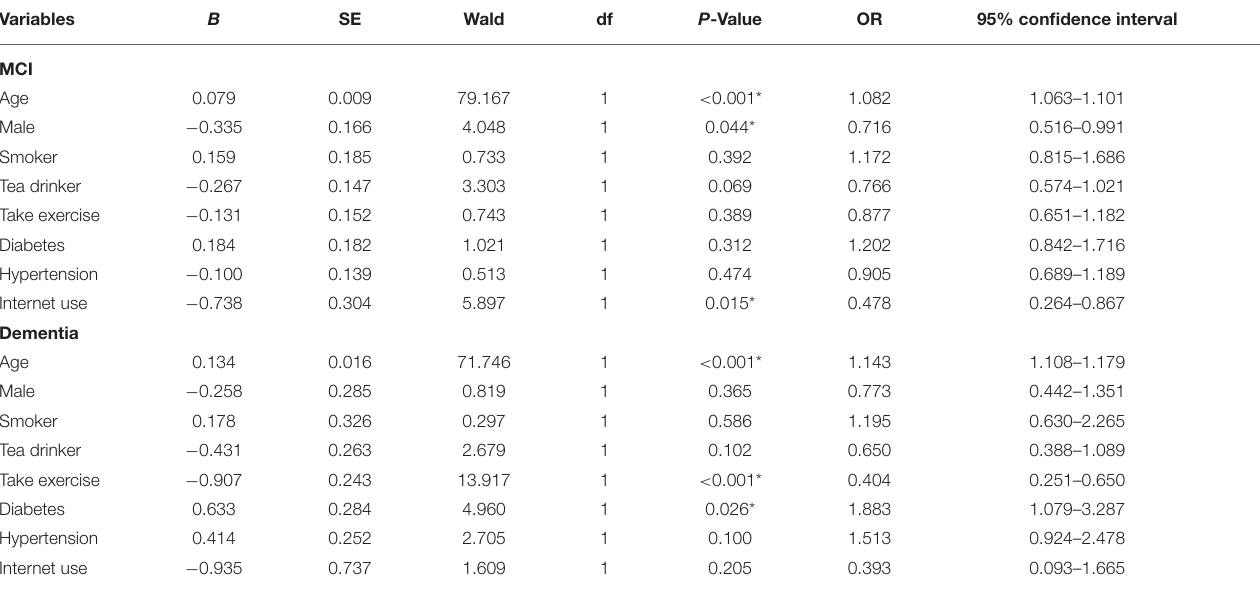
TABLE 2 | Association of internet use with cognitive change (MCI or